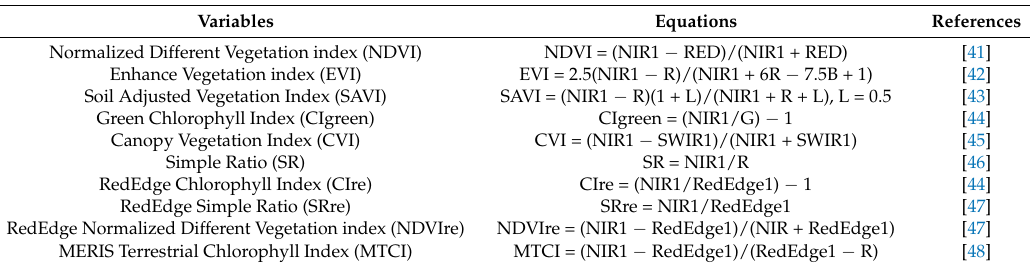
Table 4. A summary of vegetation indices used in